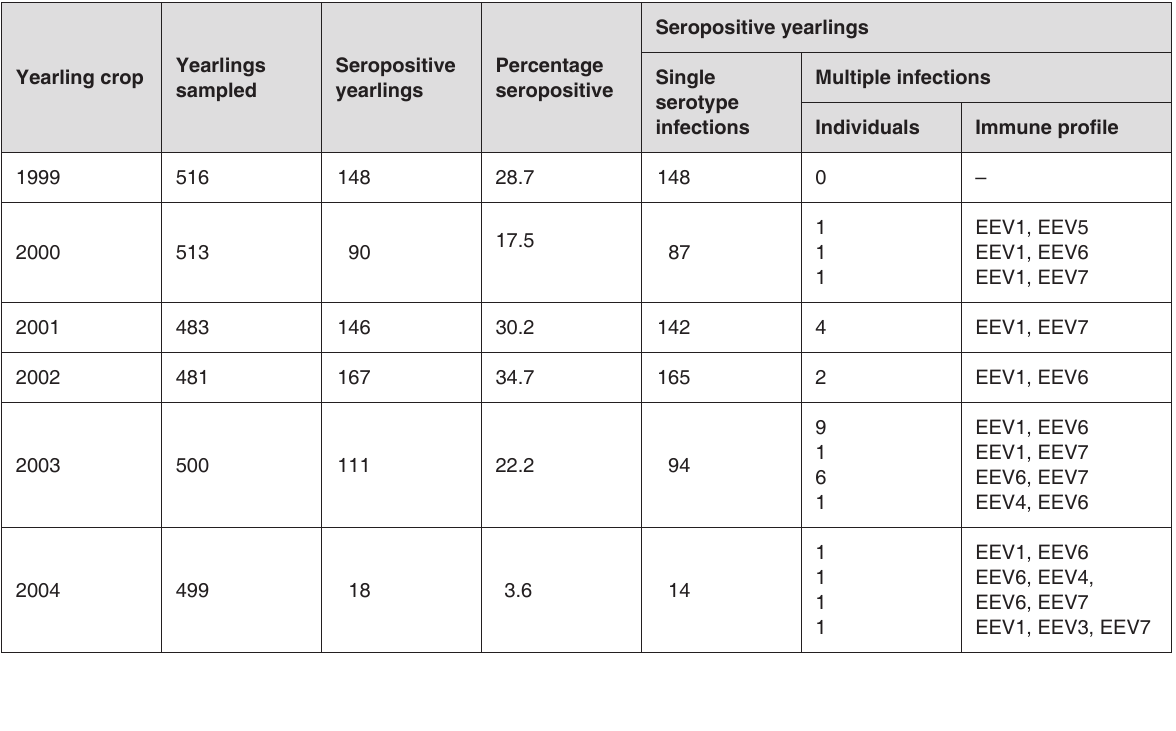
TABLE 3 Prevalence of primary and multiple serotype infection of yearlings